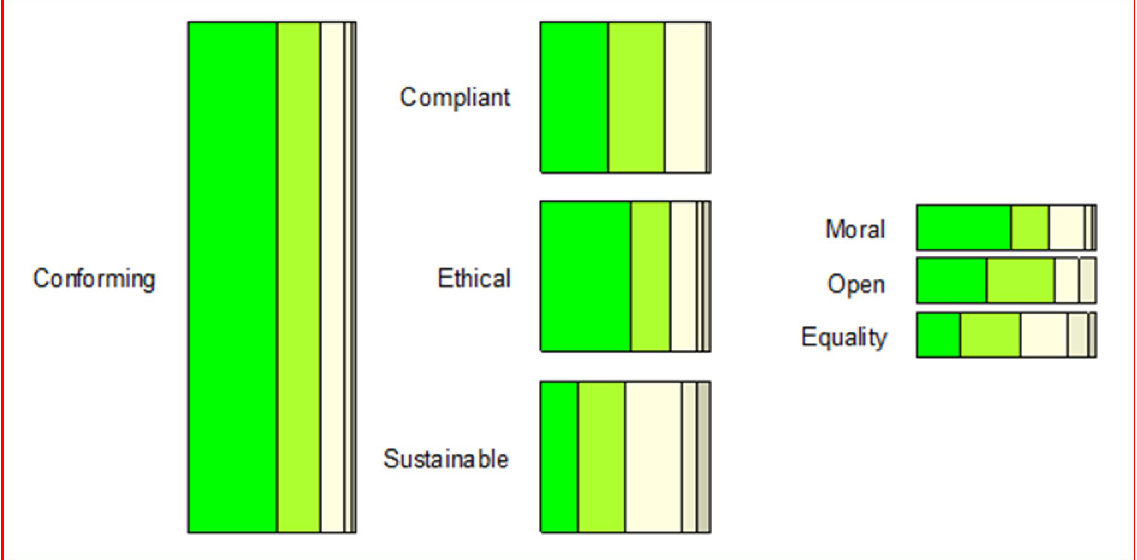
Fig 5. Responses regarding the conforming main concept, ranked from 1–5, where 5 is “of crucial importance”.